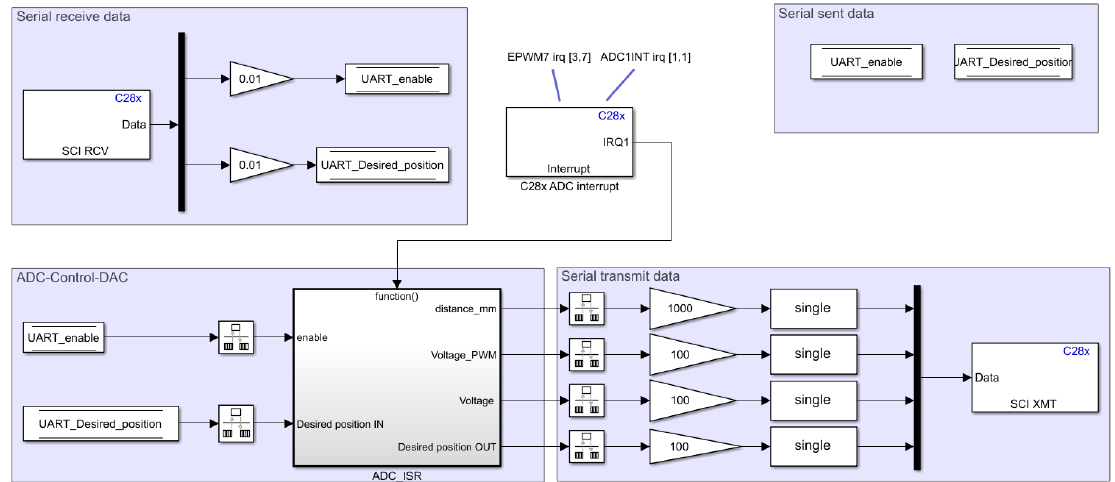
Figure 6. Simulink model for DSP implementation with serial communication.